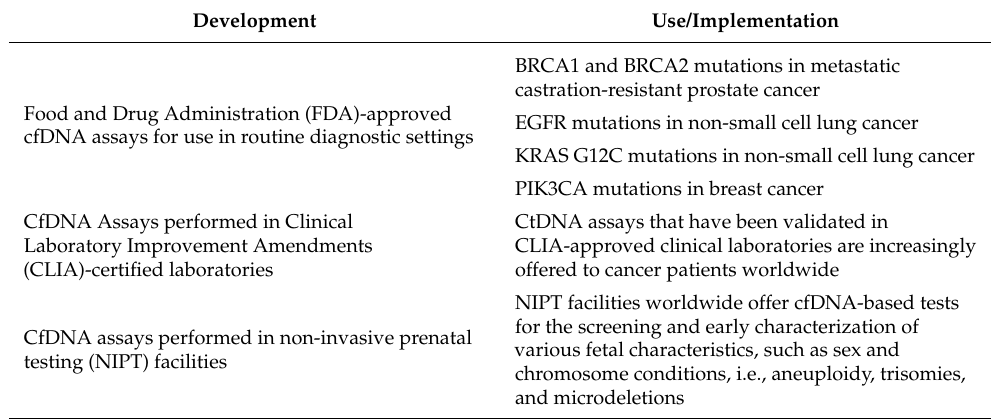
Table 1. Developments that demonstrate the potential clinical utility of sequence-specific cfDNA